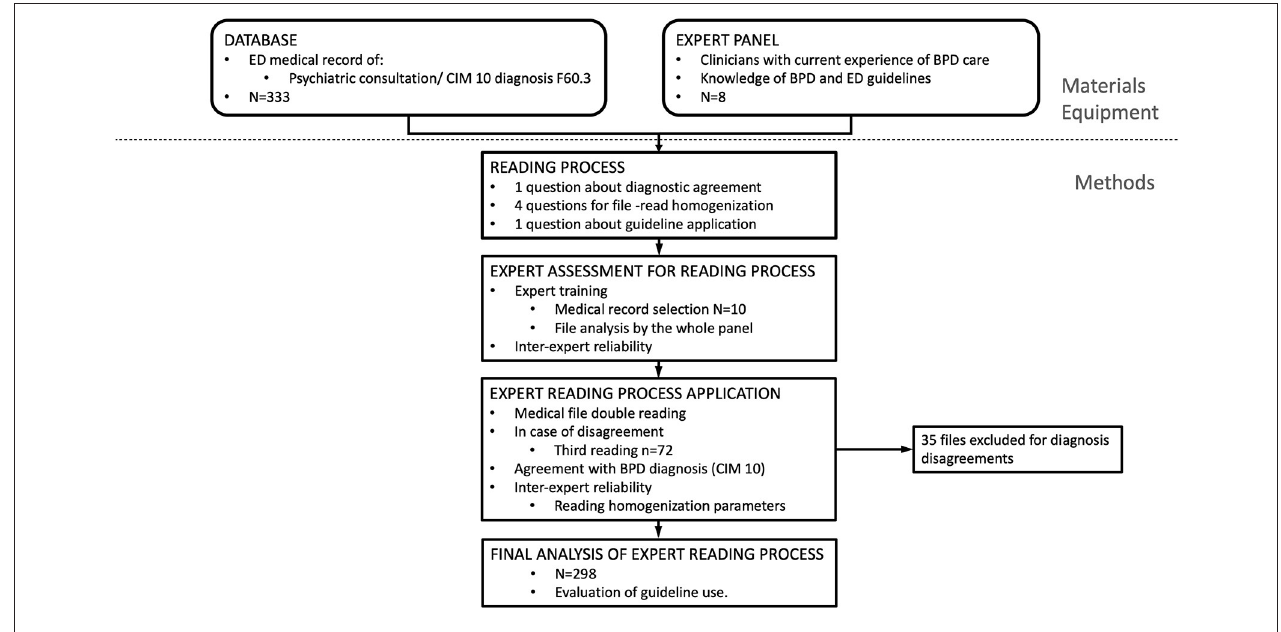
FIGURE 1 | Methods’ design.